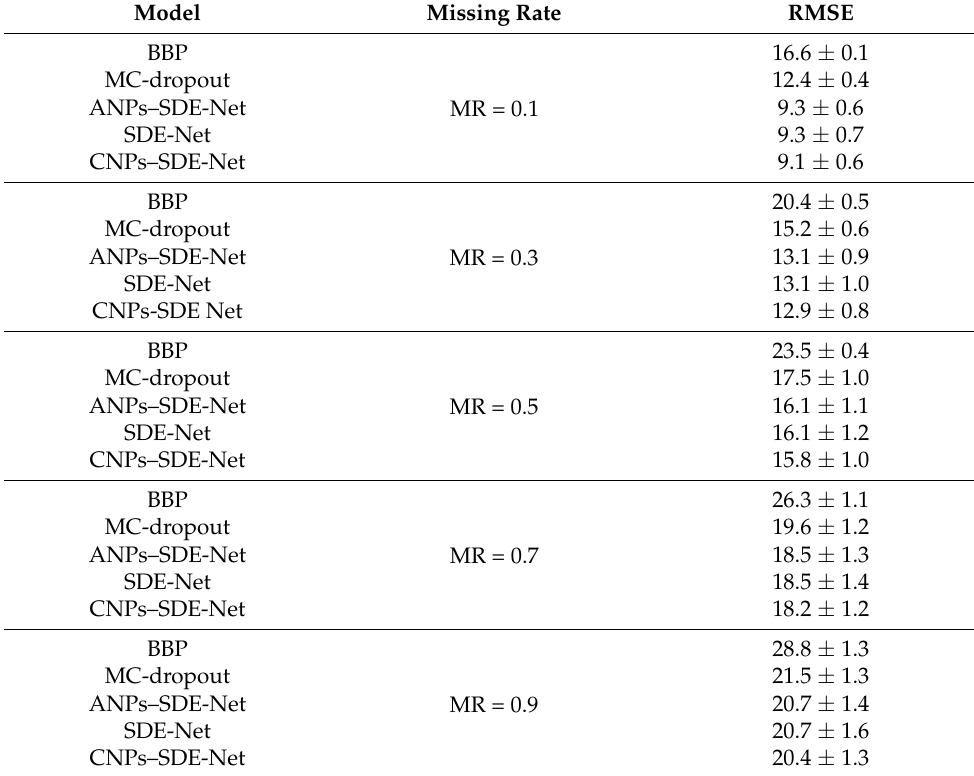
Table 1. ID dataset YearPredictionMSD with MR.